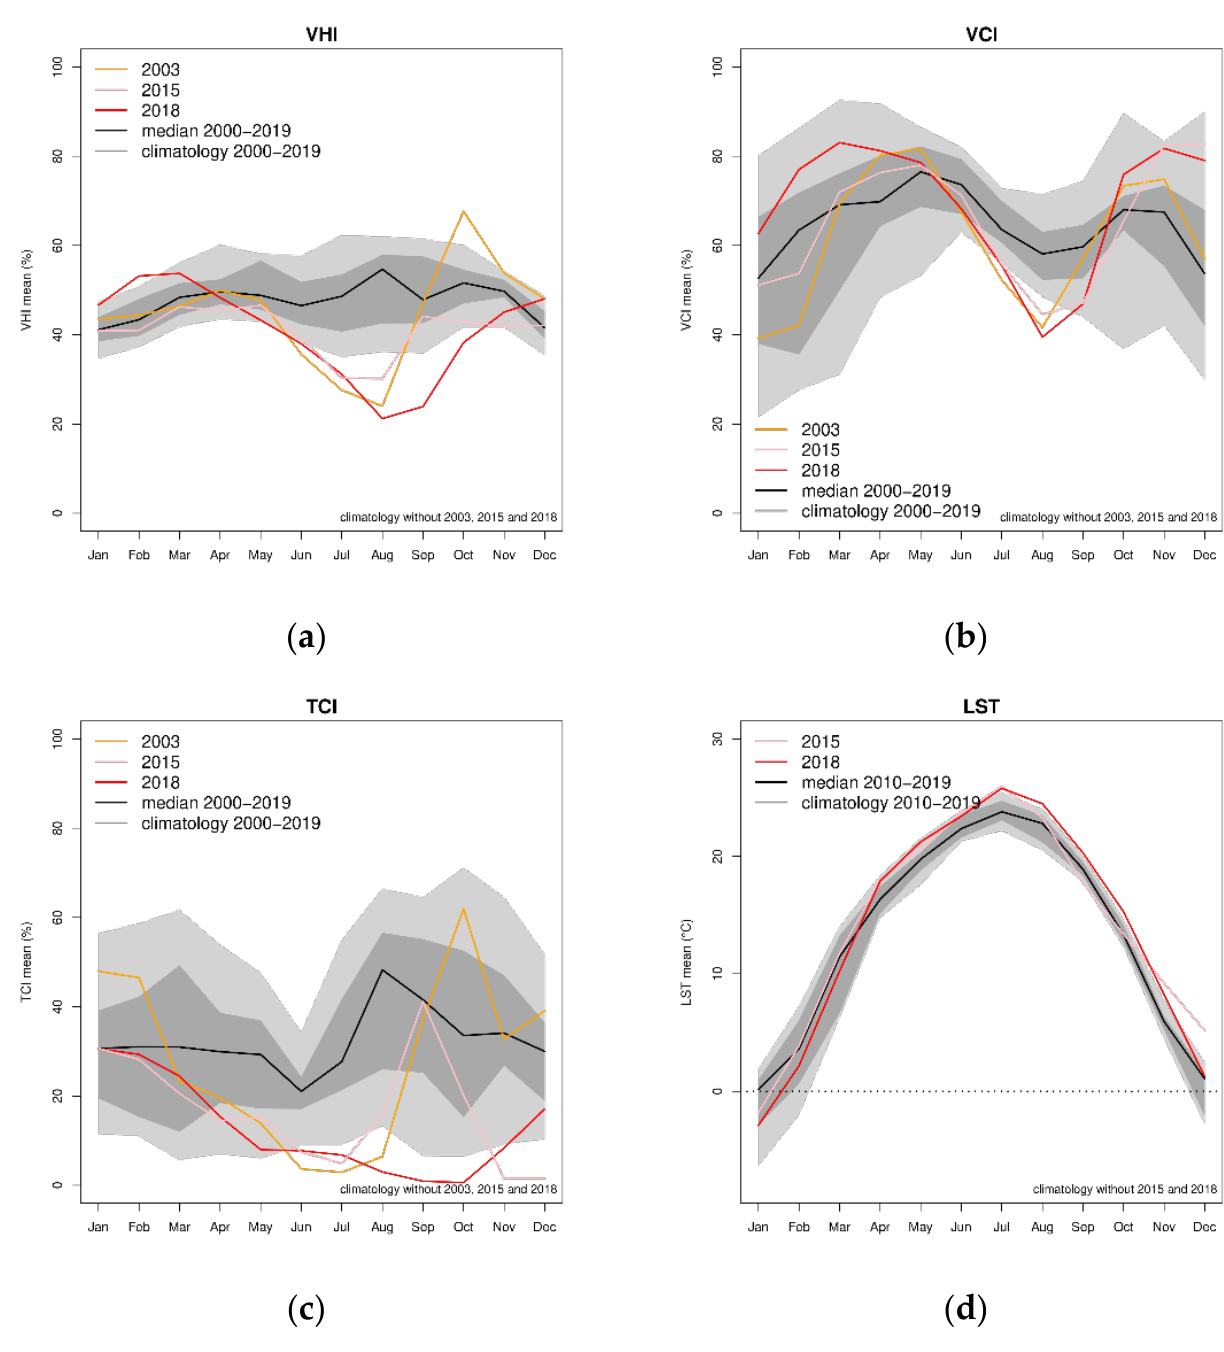
Figure 3. Seasonal evolution of monthly ( a ) vegetation health index (VHI), ( b ) vegetation condition index (VCI), ( c ) temperature condition index (TCI), and ( d ) land surface temperature (LST), averaged over the considered grassland stations. The background climatology in grey and black is based on the years of 2000 to 2019 (without the dry years 2003, 2015, and 2018) and 2010 to 2019 for LST (without the dry years of 2015 and 2018). The dark grey shading shows the 25–75% range of the respective background climatology; the light grey shading shows the 5–95% range. The evolution of the respective median as well as of the dry years is highlighted.